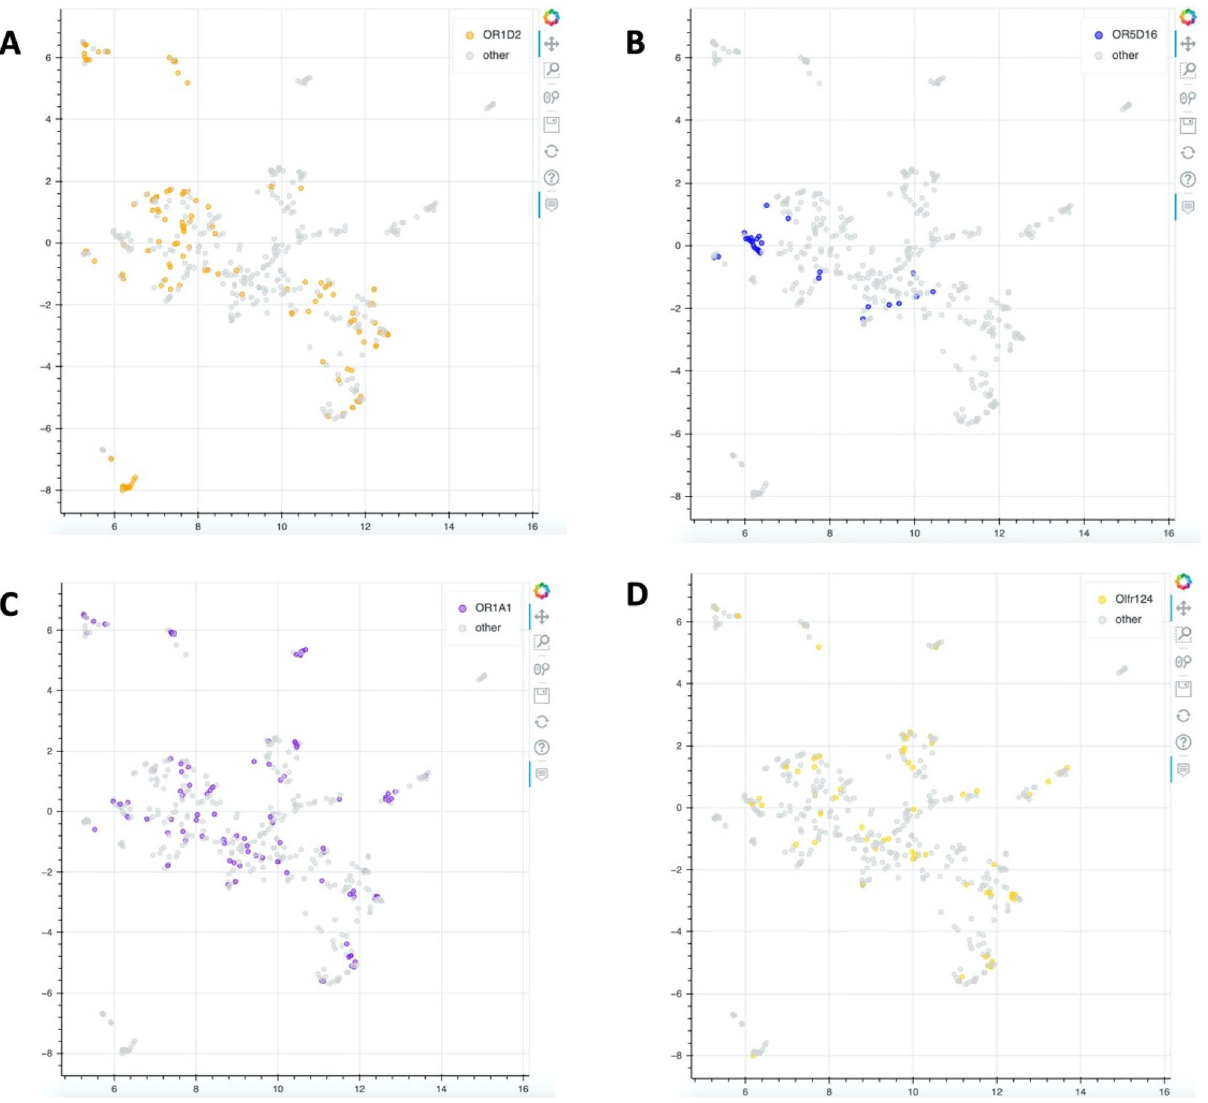
Figure 3. UMAP representation of compounds distribution in a 2D map projection. ( A ) Compounds active on OR1D2, ( B ) Compounds active on OR5D16, ( C ) Compounds active on OR1A1, ( D ) Compounds active on OR2D4. The UMAP representations were developed with the python package bokeh (v.2.4.3): https:// docs. bokeh. org/e 60